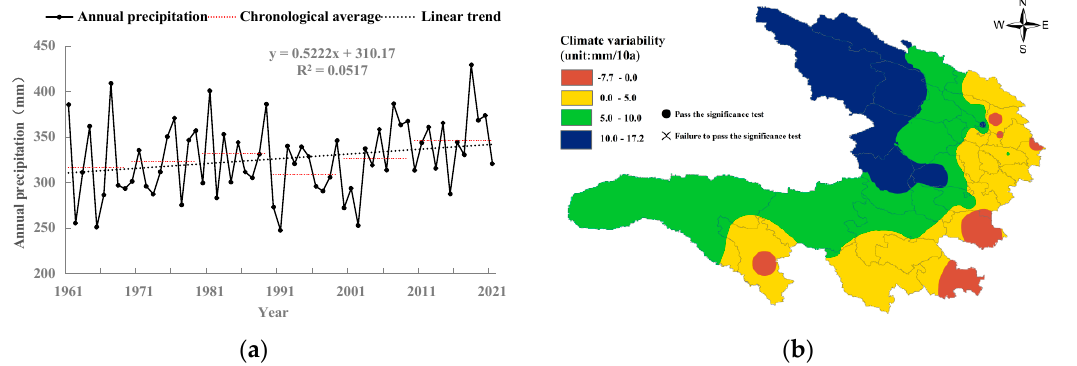
Figure 3. Variation curve ( a ) and spatial distribution of variability ( b ) of annual precipitation in the upstream of Yellow River Basin from 1961 to 2021.